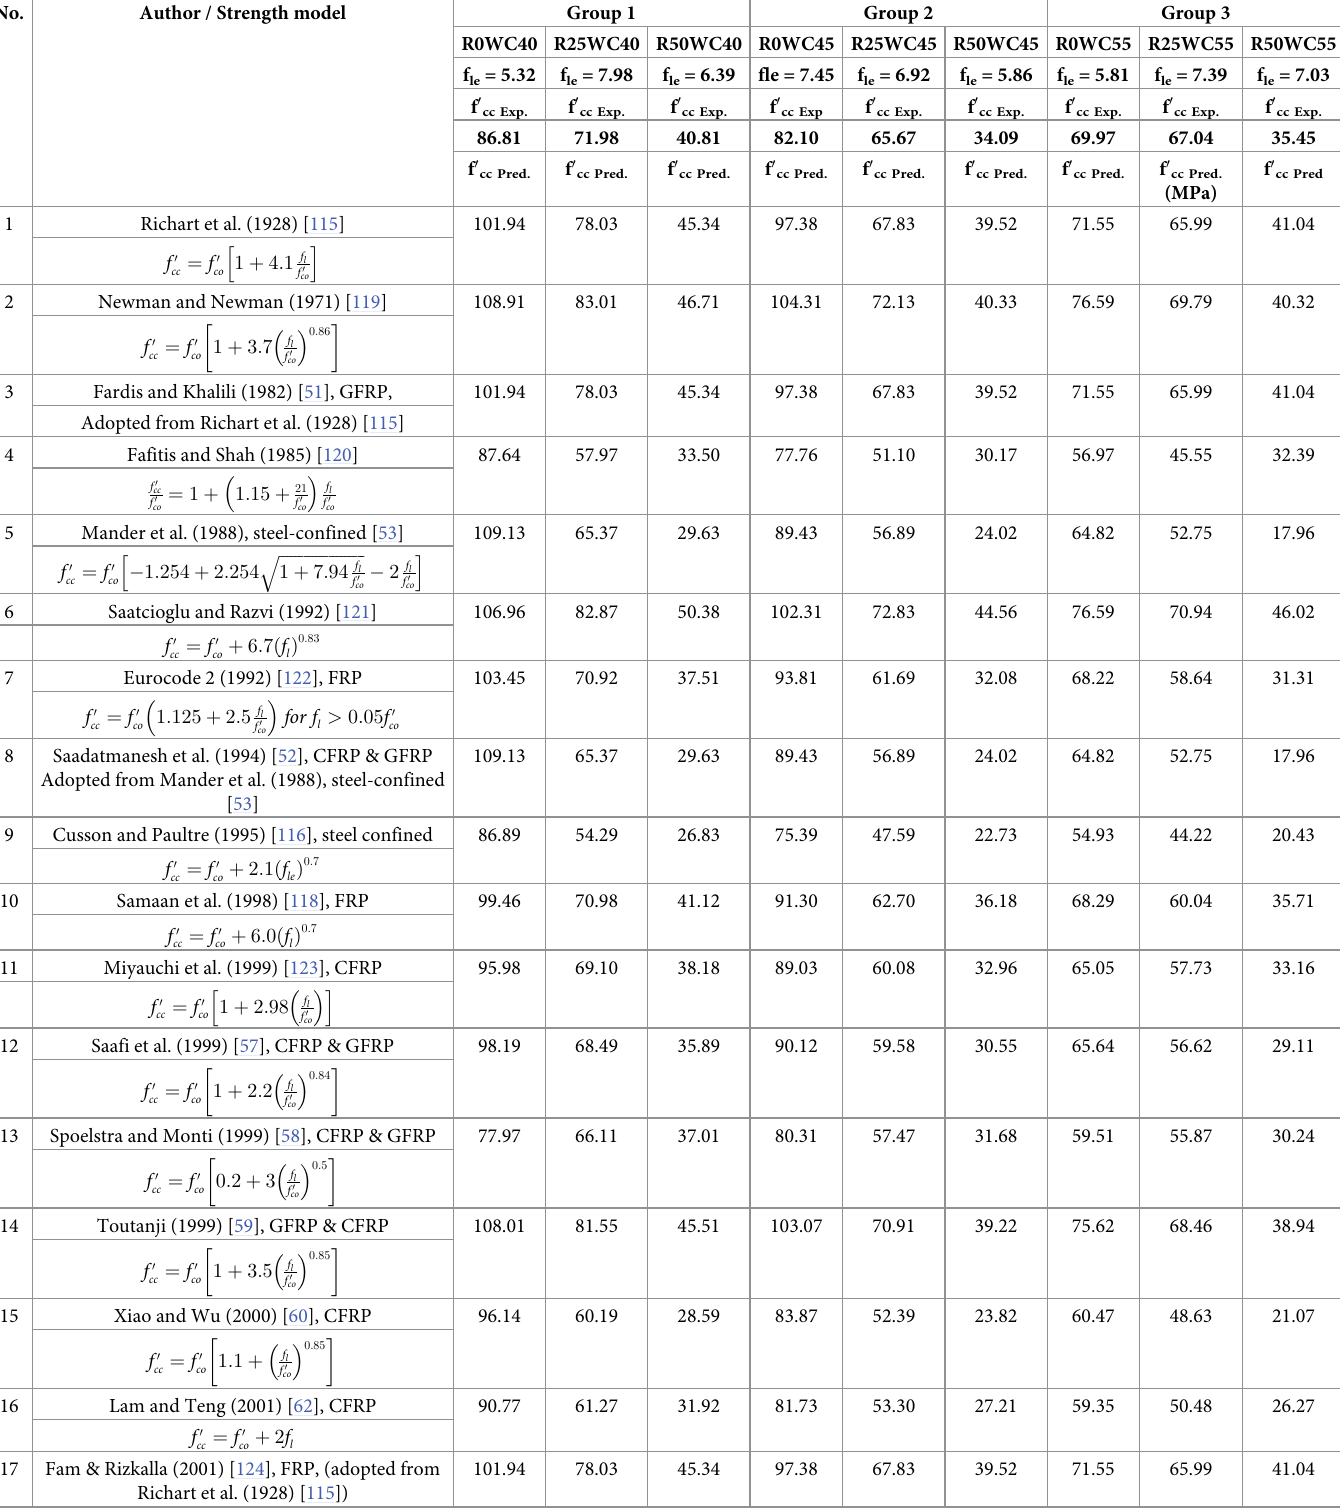
Table 10. Evaluation of existing strength models to predict f 0 cc ., MPa.